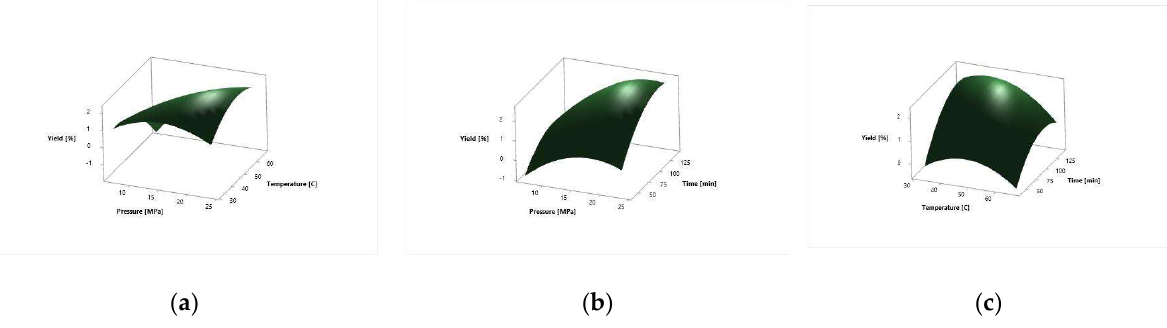
Figure 1. Surface response plots for the N. tabacum cv. Samsun leaves extraction yield in a function of extraction: ( a ) pressure and temperature; ( b ) pressure and time and ( c ) temperature and time. The surface response plots for the effect of independent variables on the N. tabacum cv. Virginia leaves total extraction yield [%] are depicted in Figure 2.